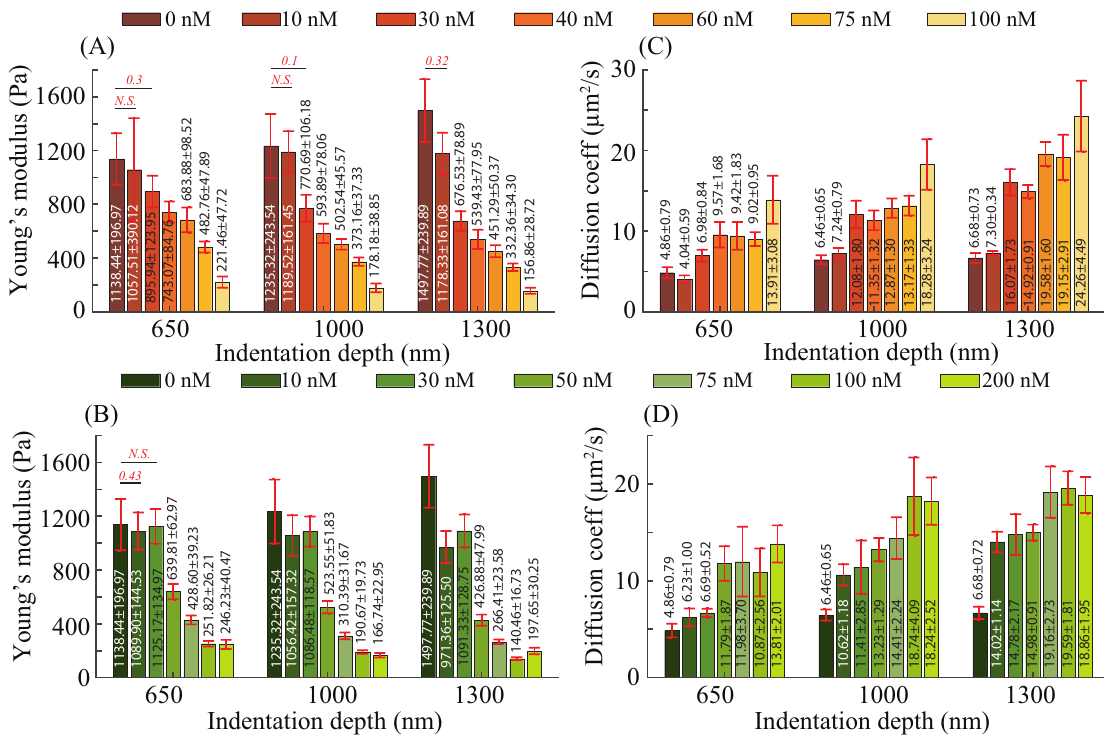
Figure 4. ( A , B ) Young’s modulus and ( C , D ) diffusion coefficient of NIH/3T3 cells treated with different treatment concentrations of ( A , C ) latrunculin B and ( B , D ) nocodazole, respectively, quantified at different indentation depths at the indenting velocity of 20 µ m/s. n ≥ 8. Error bar: standard error. Student’s t-test was performed to analyze the statistical difference: for each indentation, data